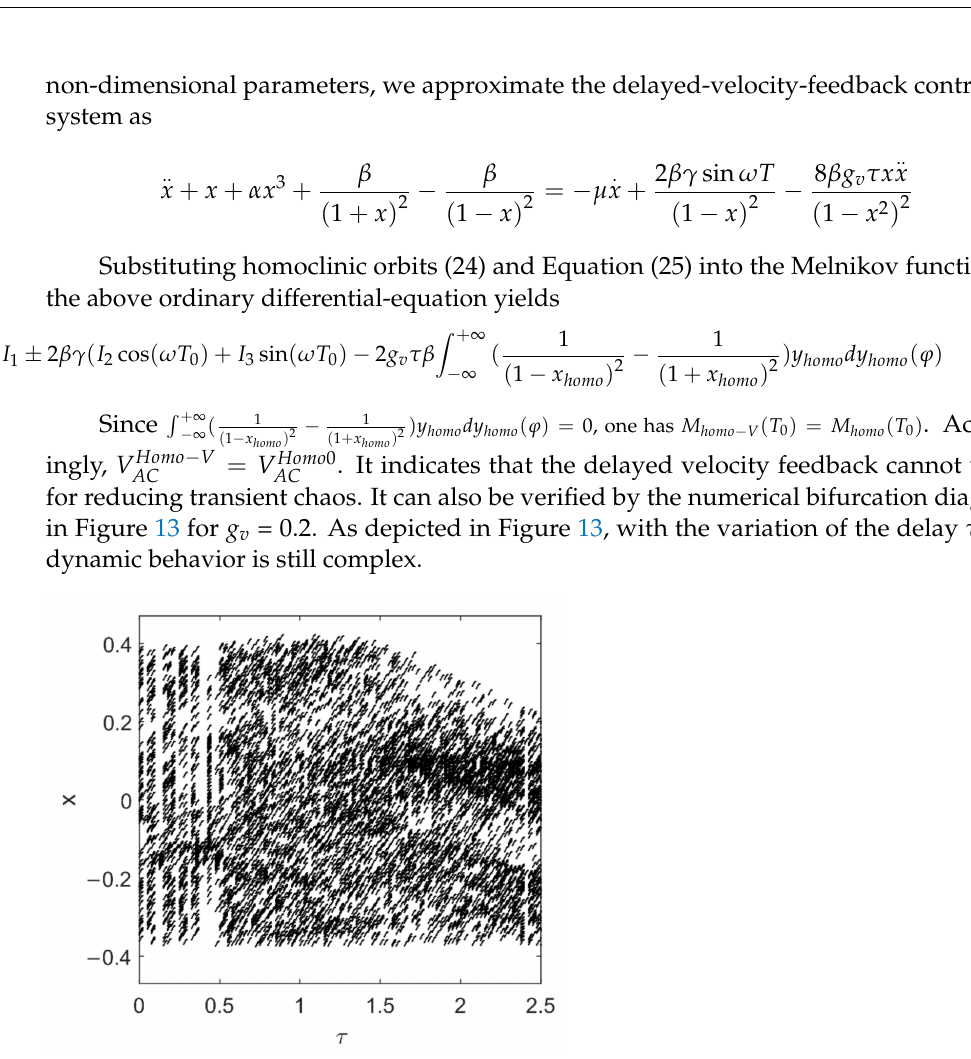
Figure 13. Bifurcation of the delayed-velocity-feedback controlled system (40) with τ in Poincar é map for g v = 0.2 and V AC = 0.16